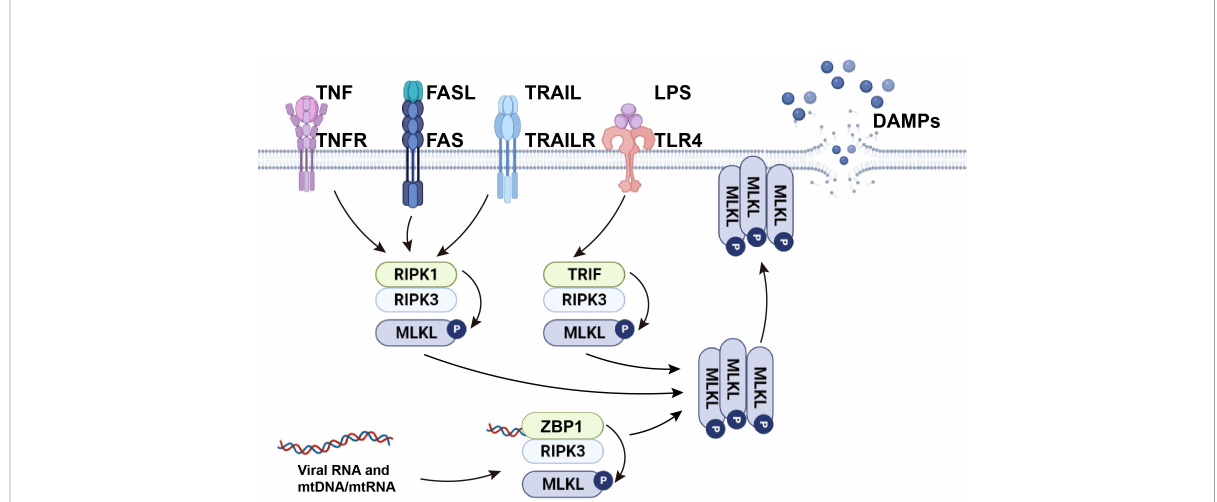
FIGURE 1 The mechanism of necroptosis. TNF and death ligands, including FasL and TRAIL, initiate necroptosis by inducing the formation of necrosome complexes. LPS activates necroptosis by TRIF-mediated necrosome complex formation. Viral RNA and cellular mtDNA/mtRNA bound to ZBP1 cause RIPK1-independent necroptosis through the ZBP1-RIPK3 complex. Activated RIPK3 phosphorylates MLKL and causes MLKL oligomerization. The oligomerized MLKL migrates to the plasma membrane, where it induces necroptosis by initiating membrane rupture and releasing